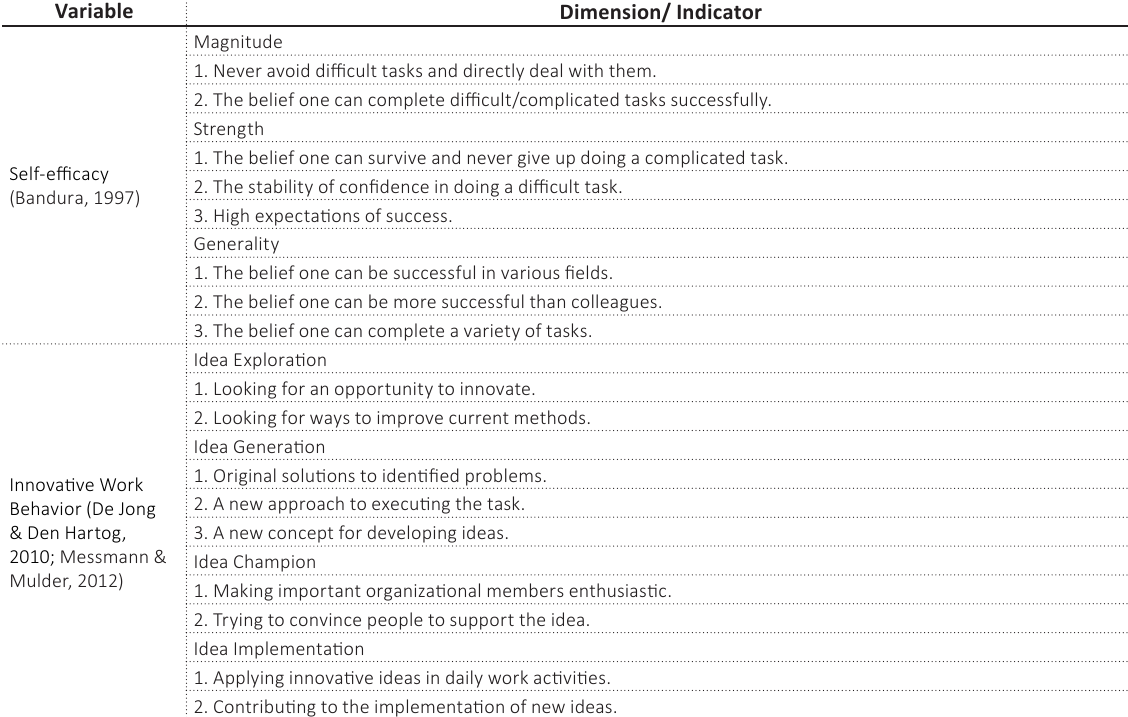
Table 1 . Construct and